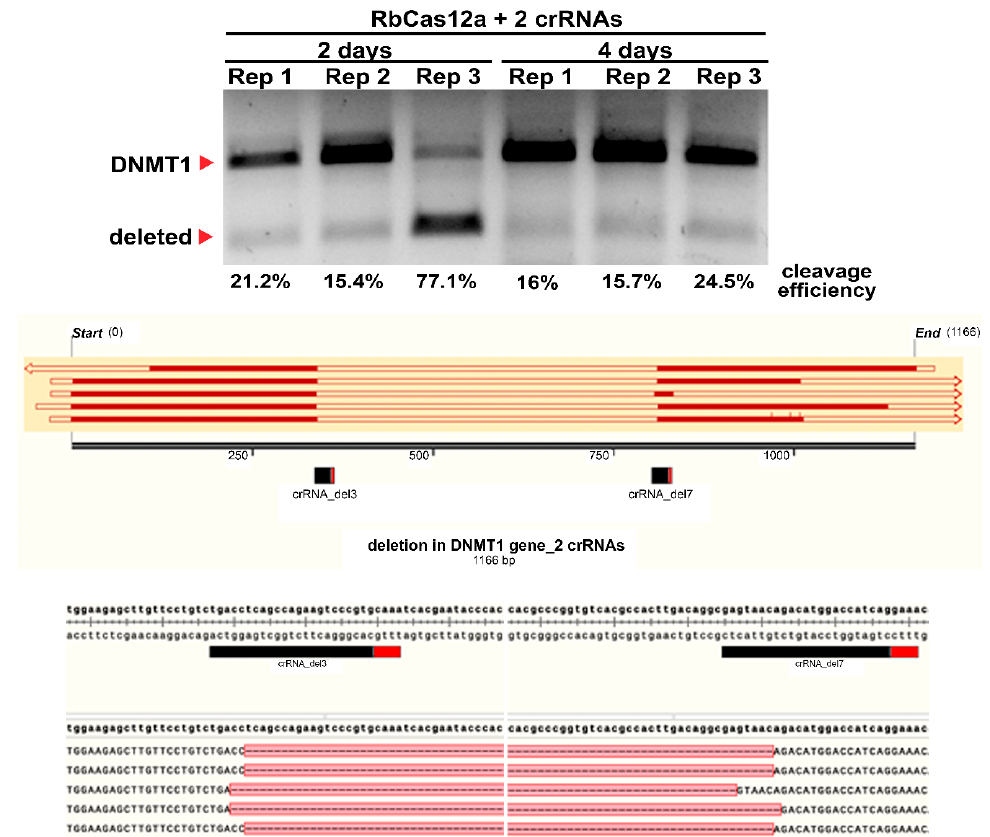
Figure 9. Targeting the human DNMT1 gene with two crRNAs led to deletions. Top: Agarose gel visualization of PCR products after cell culture transfection with plasmids encoding RbCas12a and two crRNAs. Three independent experiments are shown as Rep1–3 on the second and fourth days of the experiment. Middle: A schematic representation of the PCR product with two guide RNAs highlighted. Bottom: Detailed maps with nucleotide sequences, created with SnapGene software.